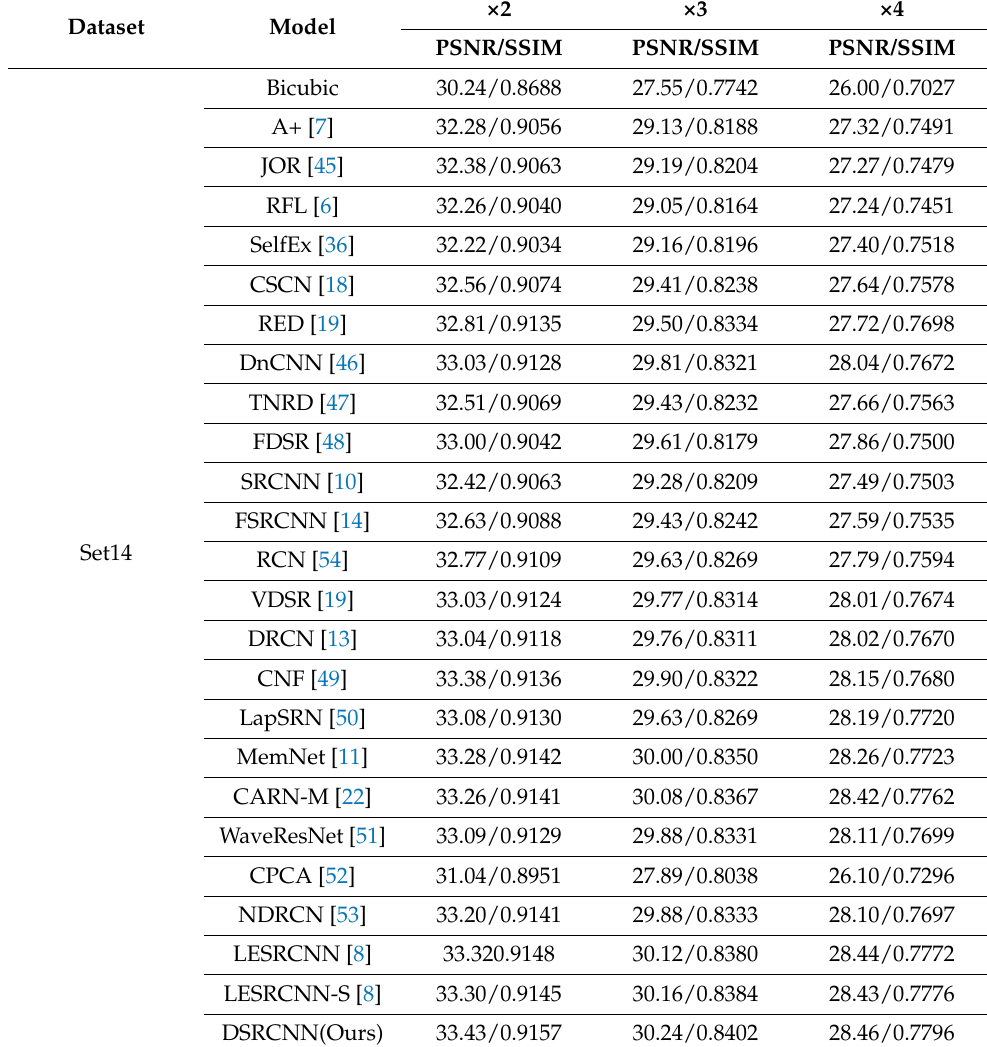
Table 3. PSNR and SSIM of different techniques with scale factors of ×2, ×3, and ×4 on Set14.